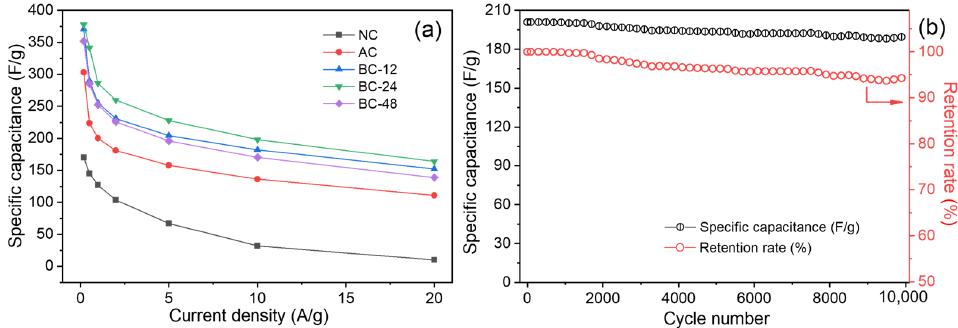
Figure 7. ( a ) Comparison of the gravimetric capacitive performance of the indicated biochar electrodes at different current densities. ( b ) Cycling stability test of BC-24 at 10 A/g.